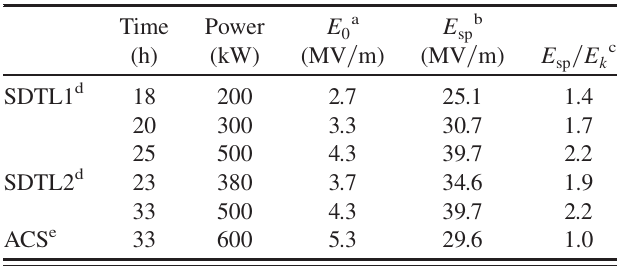
TABLE IX. Conditioning time and power levels for SDTL [11] vs ACS.